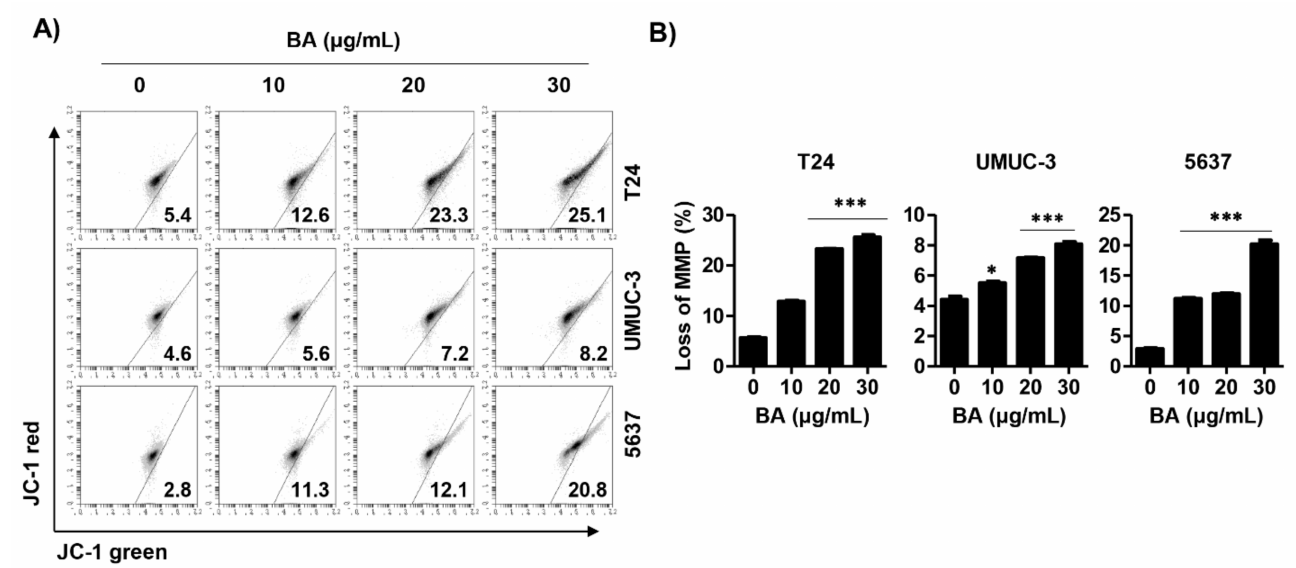
Figure 4. BA promotes mitochondrial dysfunction in human bladder cancer cells. Cells were treated with BA (0, 10, 20, and 30 µ g/mL) for 48 h. ( A ) Cells were collected, stained with 5,5 (cid:48) 6,6 (cid:48) -tetrachloro-1,1 (cid:48) ,3,3 (cid:48) -tetraethyl-imidacarbocyanine iodide (JC-1) solution, and JC-1 green levels were analyzed using a flow cytometry. ( B ) The percentages of depletion of mitochondrial membrane potential (MMP) were quantified. Data are expressed as the mean ± SD ( n = 3). * p < 0.05 and *** p < 0.001 vs. untreated control